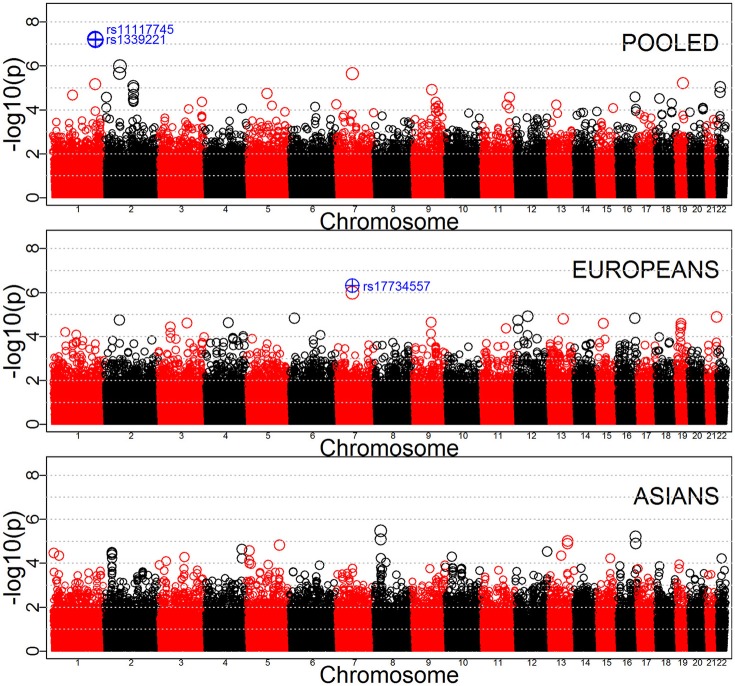
Manhattan plots for GxVitamin effects in the pooled, Europeans-only and Asians-only analyses. SNPs with p-values below 10−6 are shown in blue.